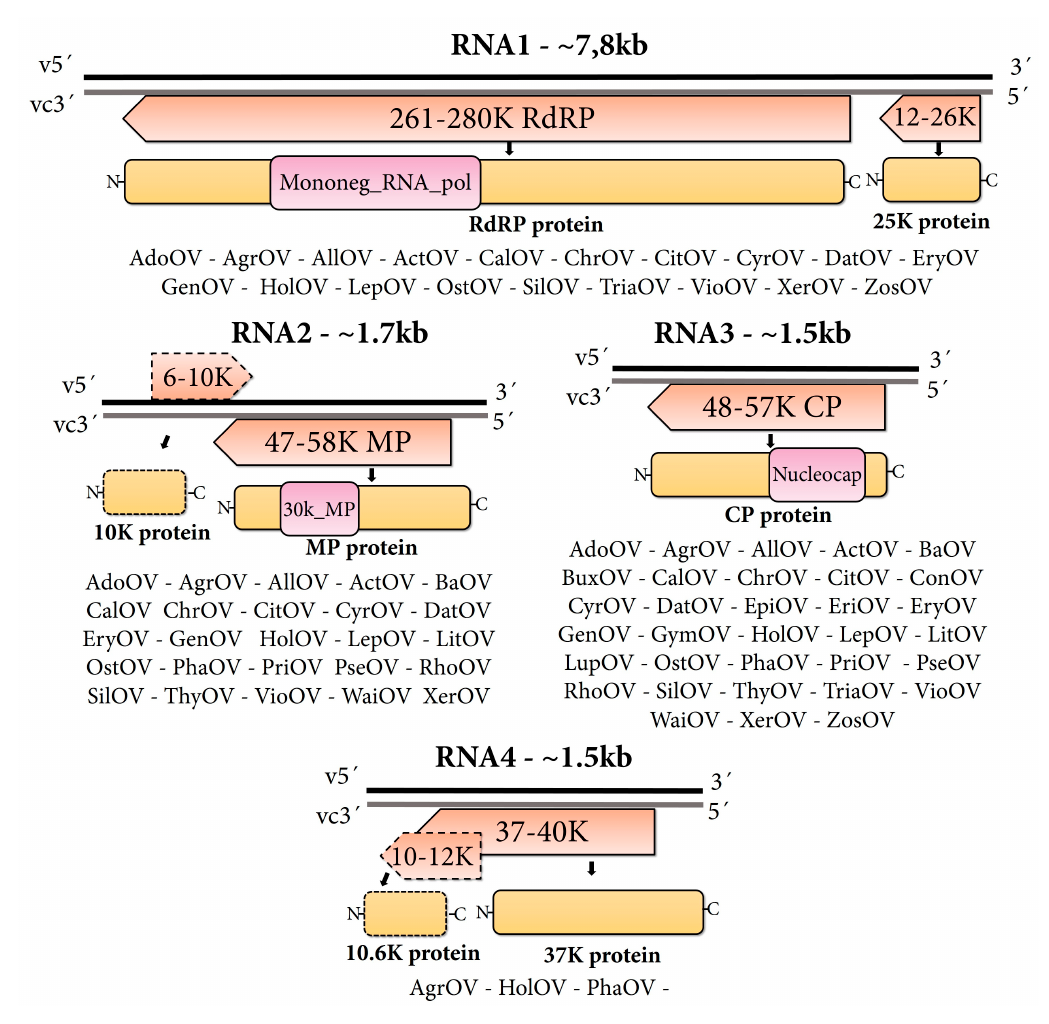
Figure 1. Genomic architecture of ophioviruses detected in this work. Genome graphs depicting organization and predicted gene products of each RNA segment. The predicted coding sequences are shown in orange arrowed rectangles. Gene products are depicted in curved yellow rectangles and their name is indicated below based on the general genome architecture. Dotted rectangles represent less common ORFs. Sizes in nucleotides and molecular weights in kilo Daltons of predicted proteins are indicated. Abbreviations: CP, capsid protein CDS; R, RNA-dependent RNA-polymerase CDS; MP, movement protein; v, virus RNA strand; vc, virus complementary RNA strand. Virus abbreviations are described in Table 1.